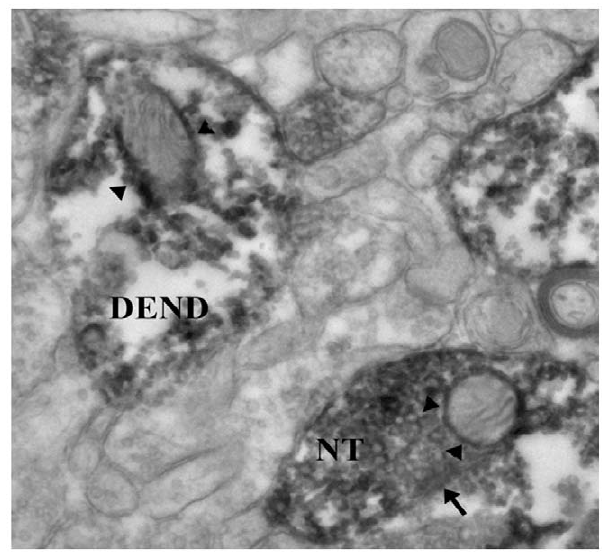
Figure 4. Mitochondrial localization of CART in mouse brain. In the mouse nucleus accumbens determined by electron microscopy. The dark diaminobenzidene reaction product shows that CART is located in a nerve terminal (NT) making a symmetrical synaptic contact (arrow) onto a neuronal cell body. Within the NT is a mitochondrion in which there is CART labeling (arrowheads) around the outer and the inner mitochondrial membranes. Within the photograph is a CART-labeled dendrite (DEND) in which there is a mitochondrion showing CART labeling, particularly along the outer mitochondrion membrane (arrowheads). Magnification: 6 40,000.